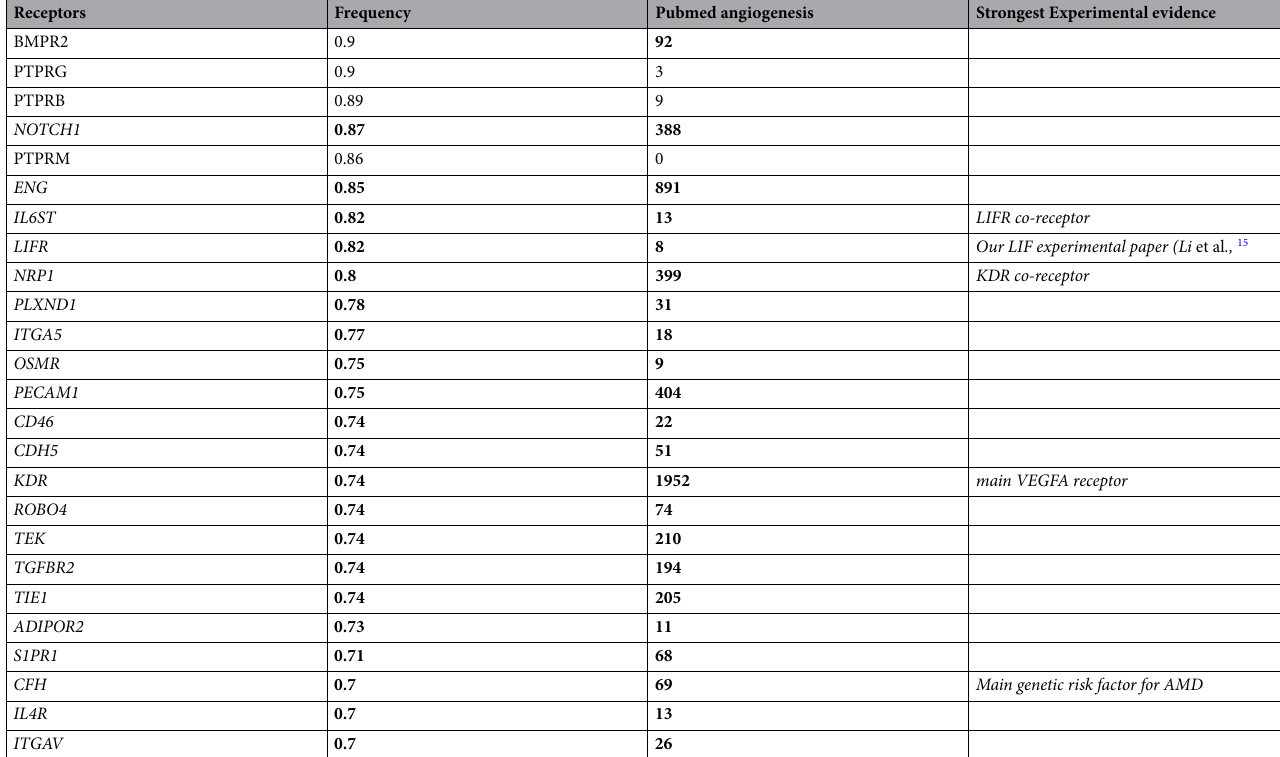
Table 2. The receptors in the main comberon of human choroid endothelial cells. All the receptors with substantial evidence for a role in angiogenesis are shown in